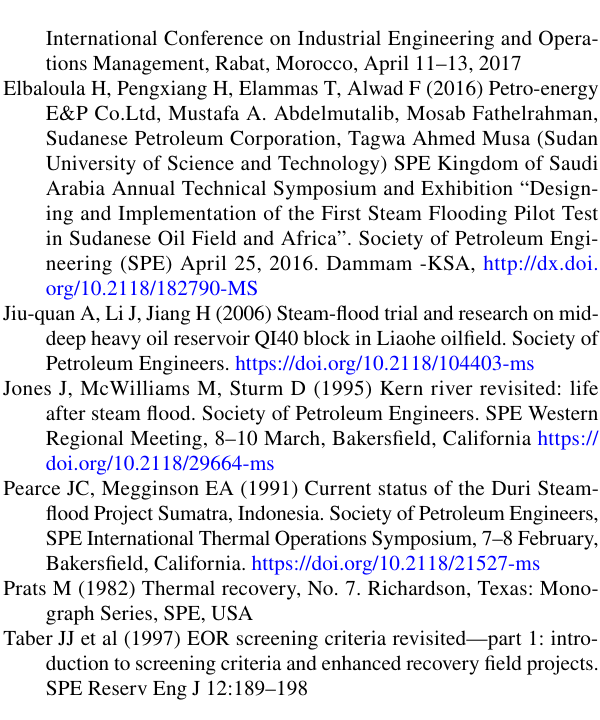
Taber JJ et al (1997) EOR screening criteria revisited—part 1: intro- duction to screening criteria and enhanced recovery field projects. SPE Reserv Eng J 12:189–198